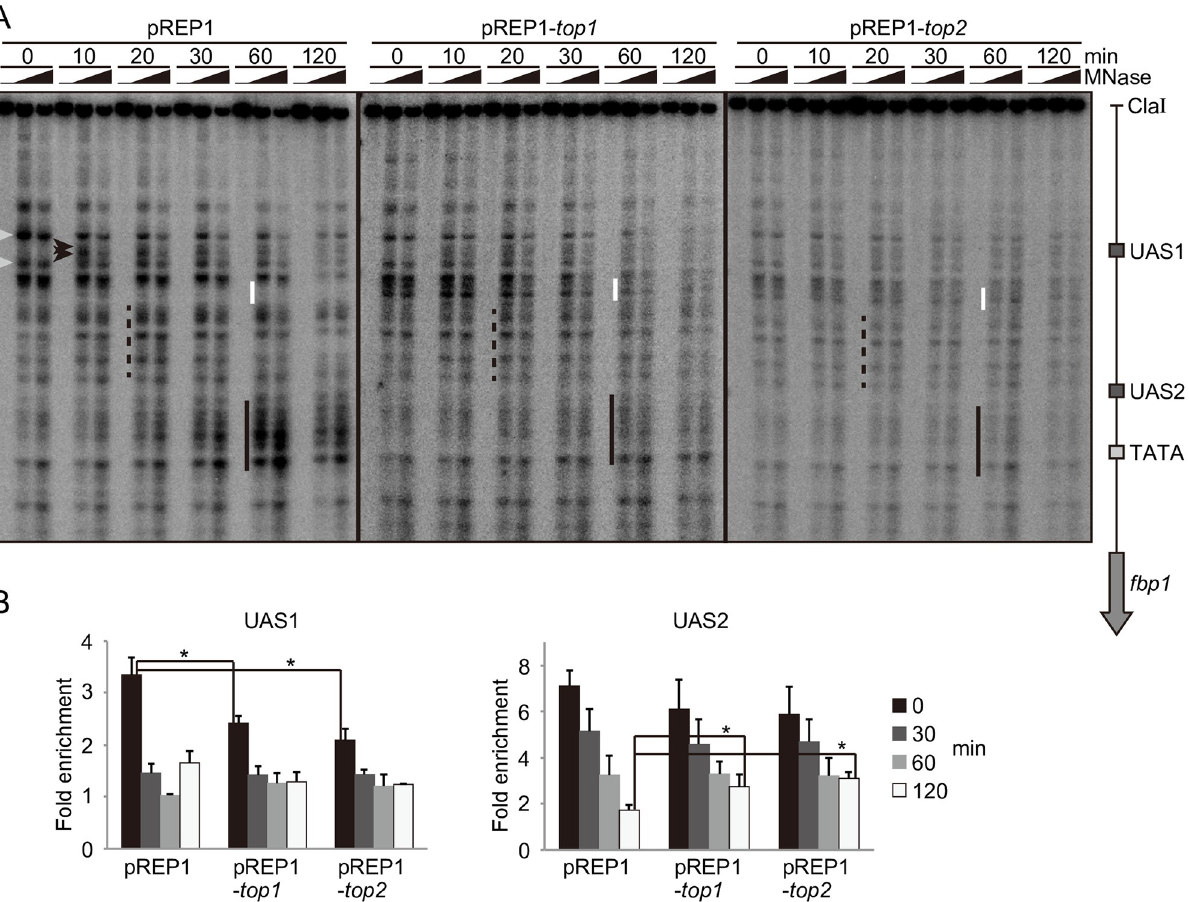
Fig 3. Aberrant chromatin configurations form in the fbp1 upstream region in topoisomerase-overexpressing cells. (A) Chromatin was analyzed by MNase partial digestion assay in the indicated cells. Cells were cultured as shown in Fig 2. The isolated chromatin DNA was digested with 0, 20, and 50 U/mL MNase. Gray arrowheads represent MNase sensitive sites around UAS1 appeared before glucose starvation. Black arrowheads represent MNase sensitive sites within UAS1. Dotted and black lines represent MNase sensitive sites appeared in glucose starvation around UAS1-UAS2 and TATA box, respectively. White lines represent the region protected from MNase in glucose starvation in control cells. (B) Nucleosome occupancy was analyzed by a ChIP experiment using anti-histone H3 antibody. ChIP signals at UAS1 and UAS2 were normalized for the signal of cam1 locus as an internal control [39]. The error bars indicate standard deviation from at least two independent experiments. p -value was calculated by a Student’s t -test: � , p < 0.05.